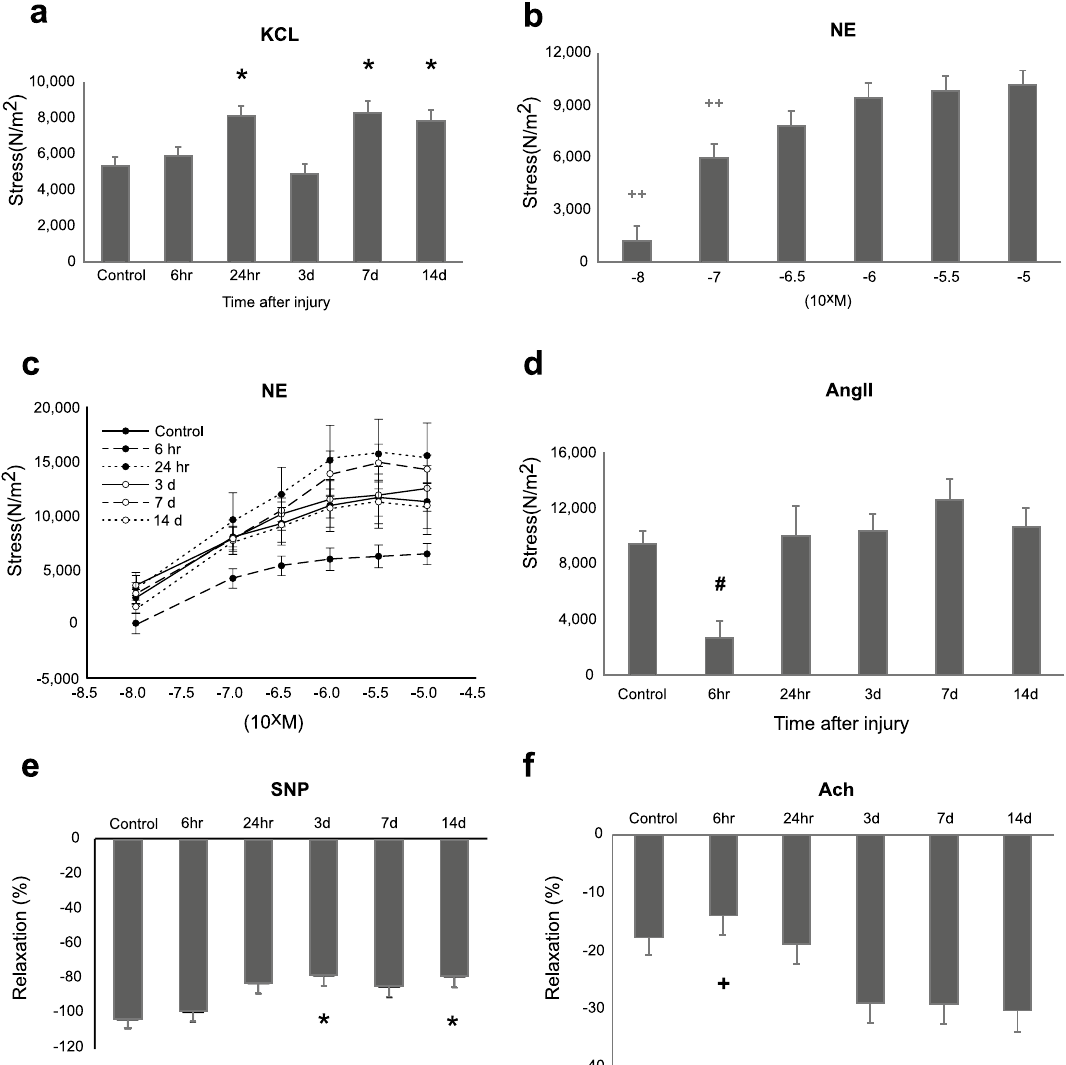
norepinephrine (NE) stimulation. + +, p < 0.05, versus higher dose groups; ( c ) The effect of days after burn on the NE dose–response of carotid smooth muscle contractility. #, p < 0.05, versus other groups; ( d ) Carotid smooth muscle contractile alterations in burn rats with AngII stimulation. #, p < 0.05, versus others; ( e ) Precontracted carotid smooth muscle relaxation in burn rats with SNP stimulation, and ( f ) Ach stimulation over the time. *, p < 0.05, versus control; +, versus 3, 7, 14 days ( d ). The number of animals was 9, 7, 7, 7, 7 and 6 in the control, 6 h, 24 h, 3 days, 7 days, and 14 days group, respectively. Two-way analysis of variance (ANOVA) with post hoc Holm-Sidak method was applied. Data were presented as mean ±